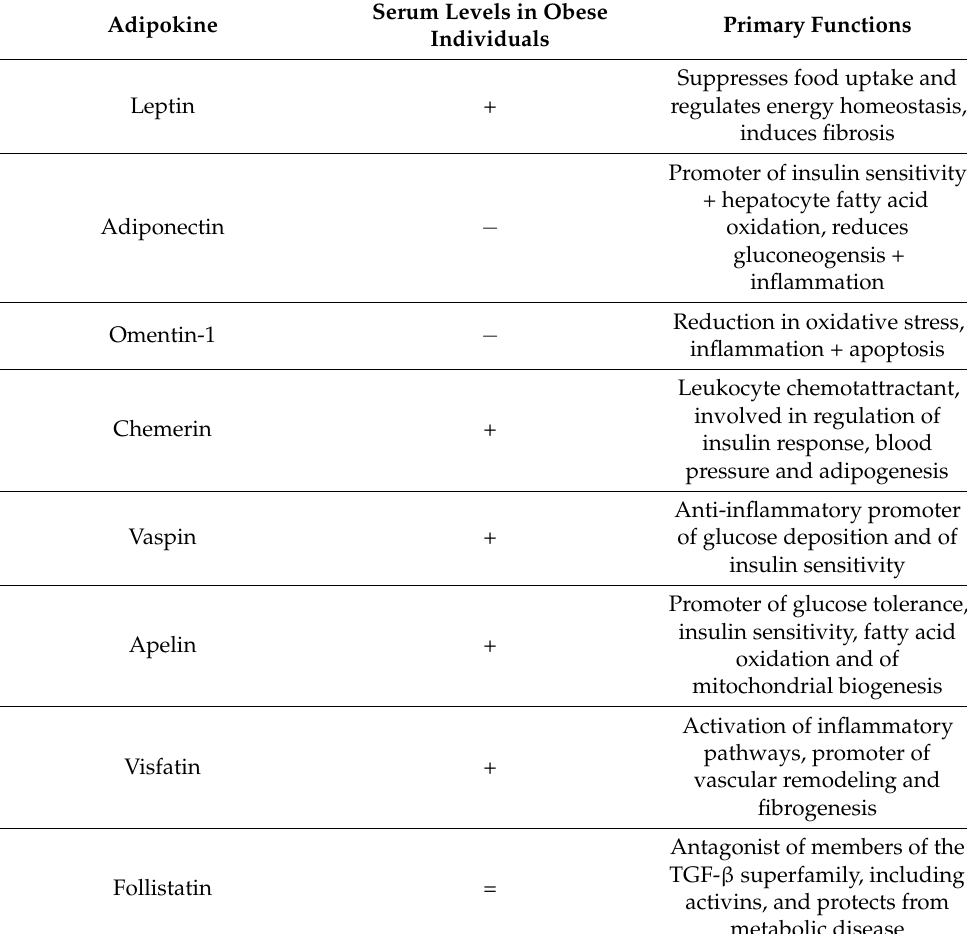
Table 1. Primary functions of the indicated adipokines and their serum levels in